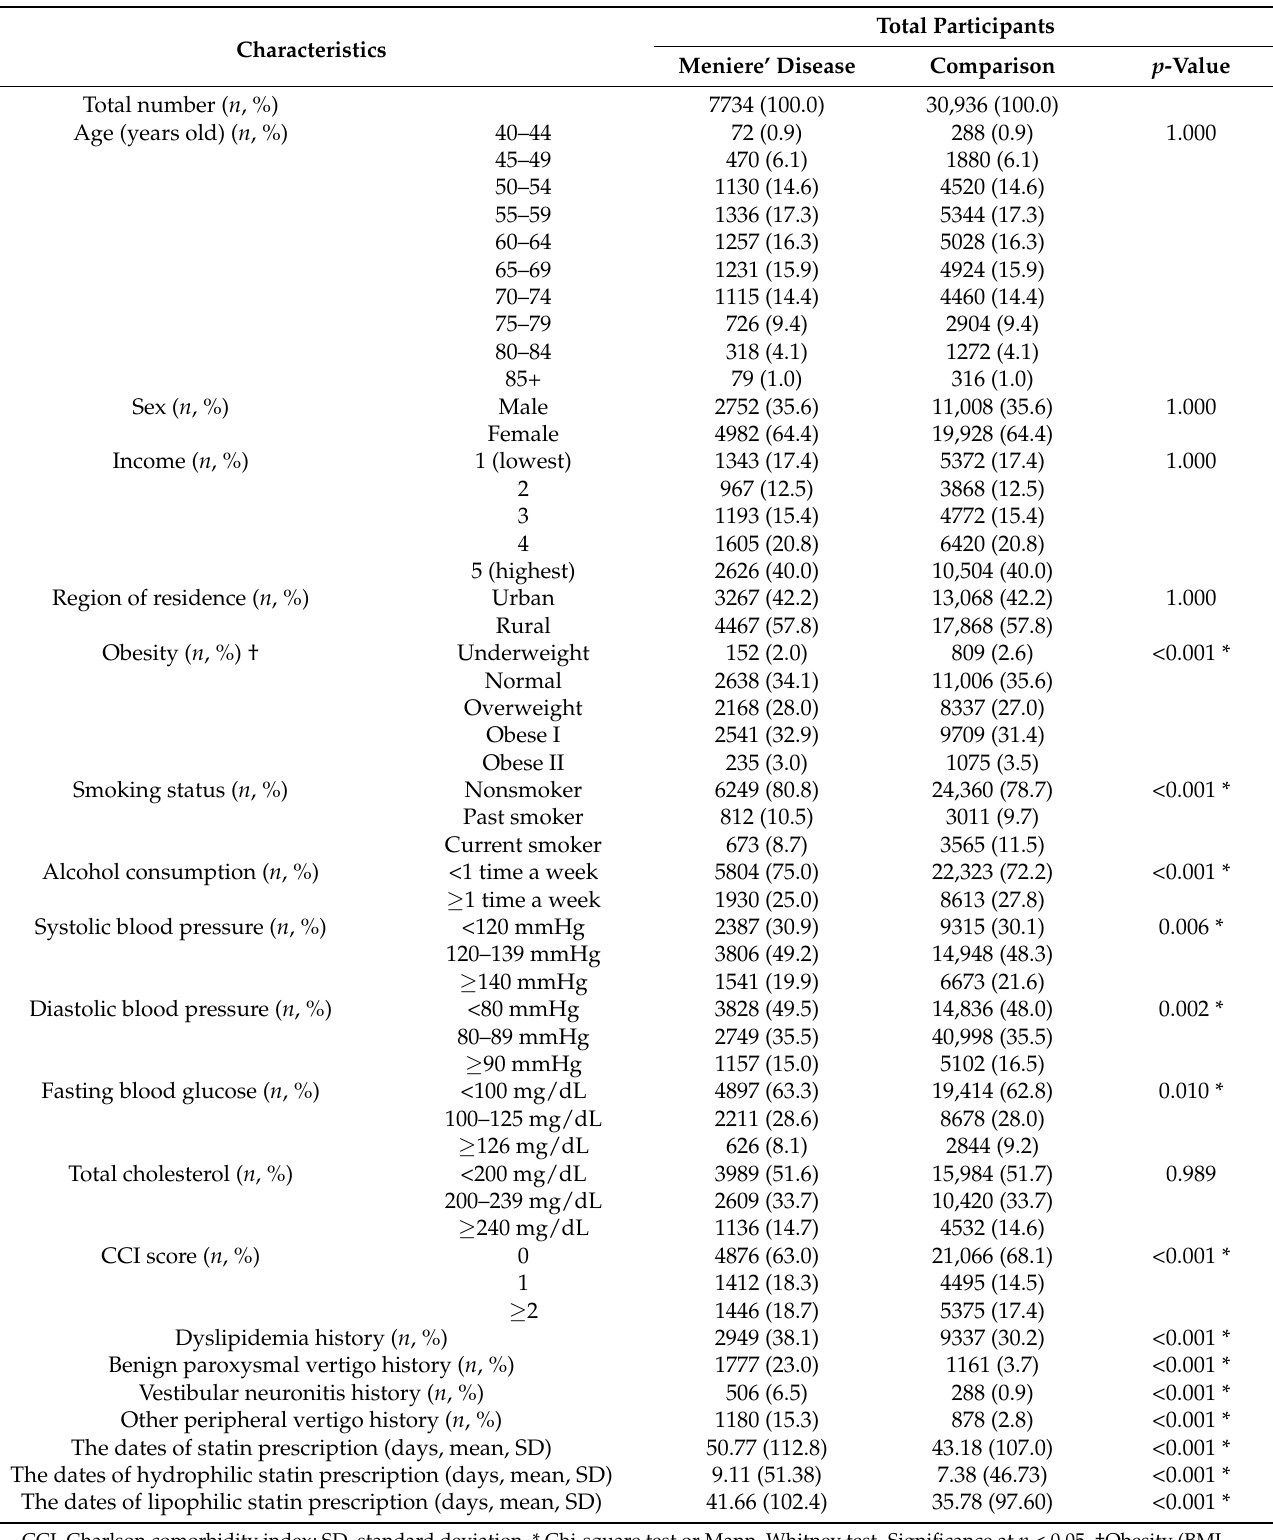
Table 1. General characteristics of the